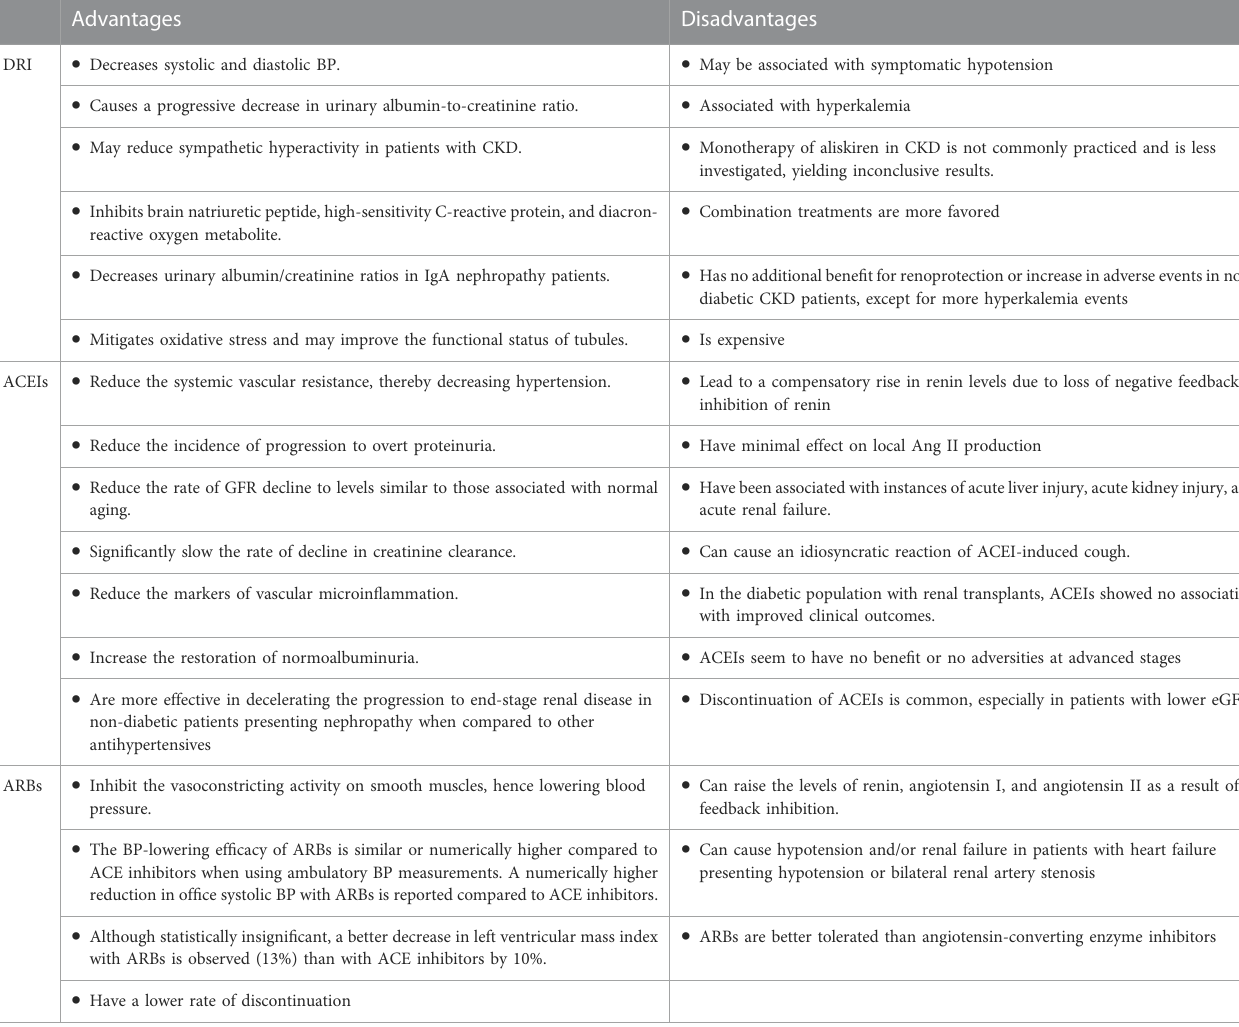
TABLE 5 Advantages and disadvantages of DRI, ACEIs, and ARBs in CKD.